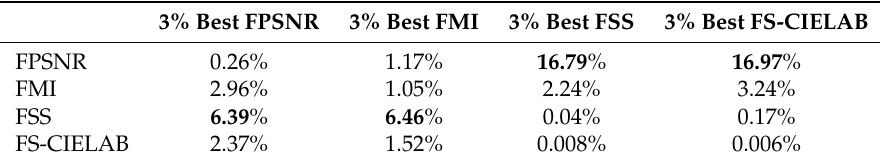
Table 3. Performance decrease (percentage) with respect to the best one according to the four evaluation metrics (see Figure